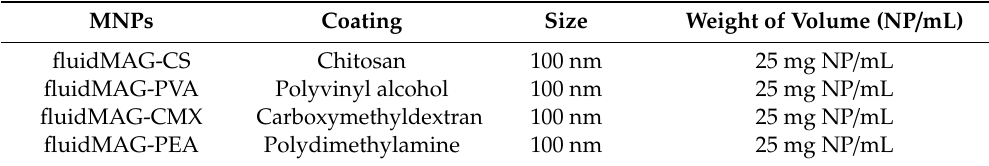
Table 1. Supplier’s reported properties of the magnetic nanoparticles (MNPs) (size, coating compound, and weight of volume) used in this study. CS, chitosan; PVA, polyvinyl alcohol; CMX, carboxymethyldextran; PEA, polydimethylamine.